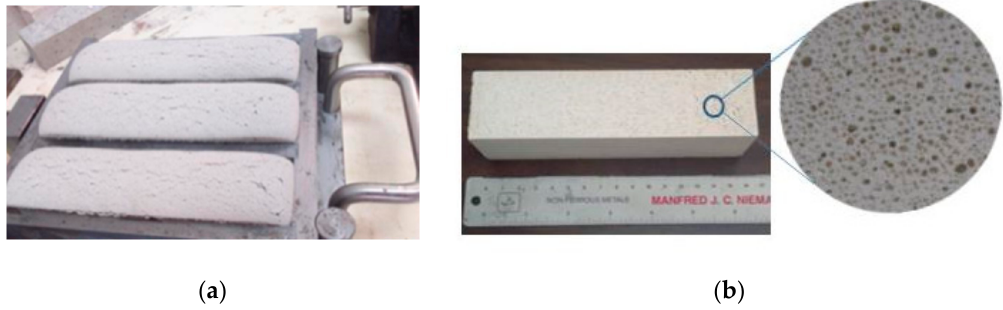
Figure 6. ( a ) Mixtures cast into 40 × 40 × 160 mm 3 molds after aeration; ( b ) specimen with flattened surface.